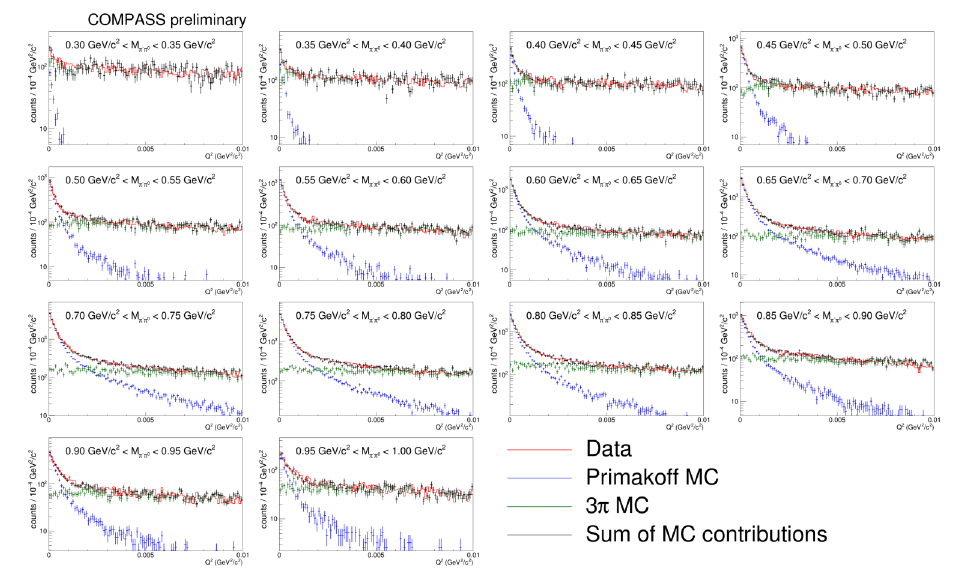
Figure 5. Three-pion background to the two-pion final states for di ff erent two-pion mass bins.